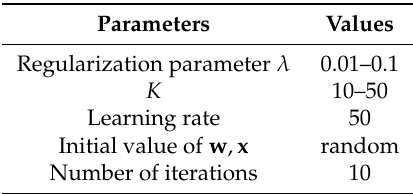
Table 2. Experiment